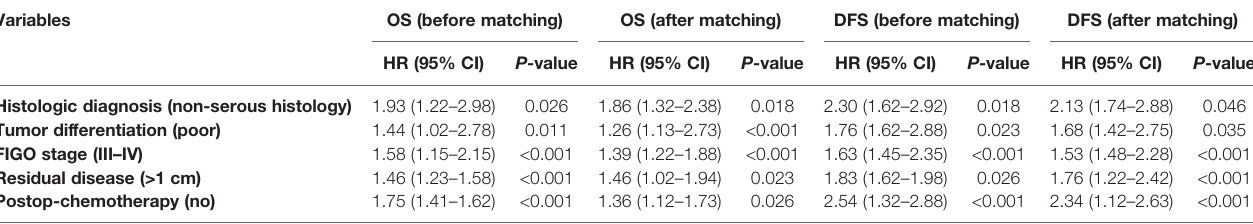
TABLE 2 | Multivariable Cox proportional of OS and